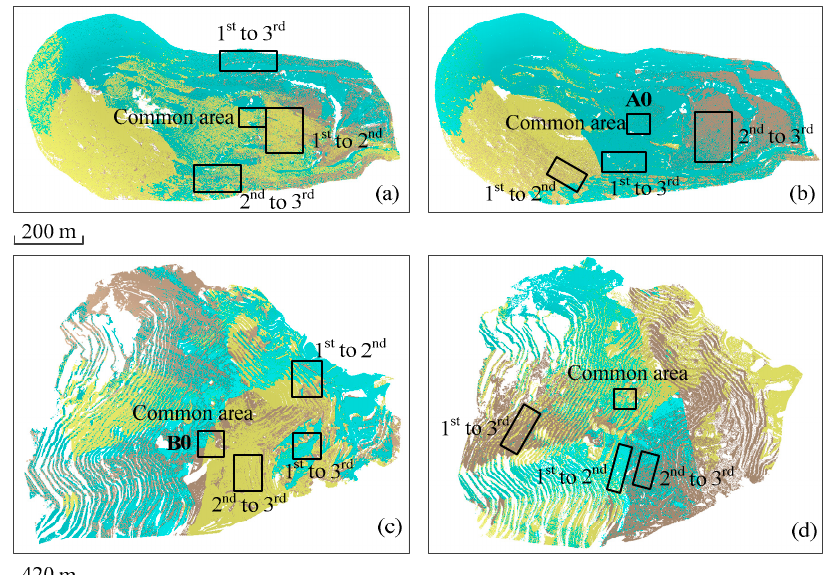
Figure 5. Registration results of TLS stations over site A acquired on ( a ) 12 September 2017, ( b ) 12